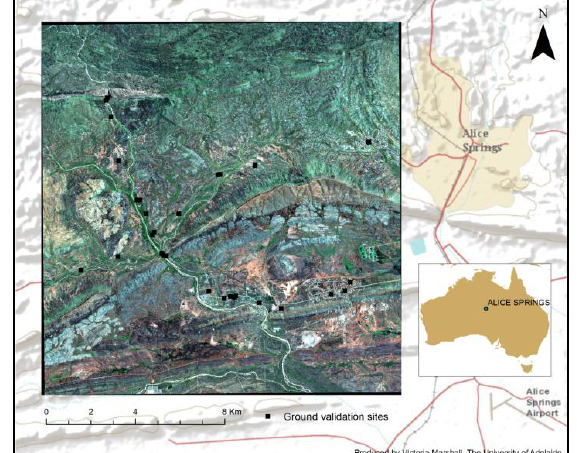
Figure 2: Study site 1km west of Alice Springs in central Australia. Worldview-2 imagery displayed in true colour covering the total extent of the study site. Ground validation sites are marked (black